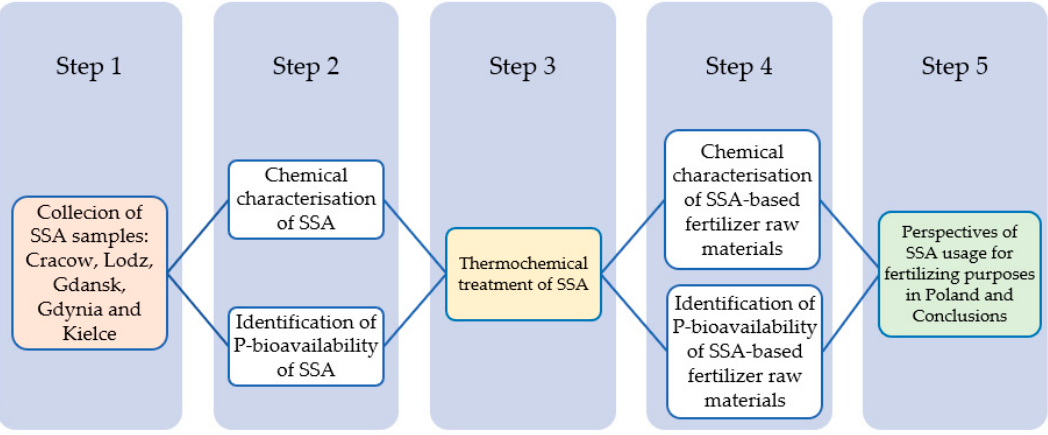
Figure 1. Research framework.